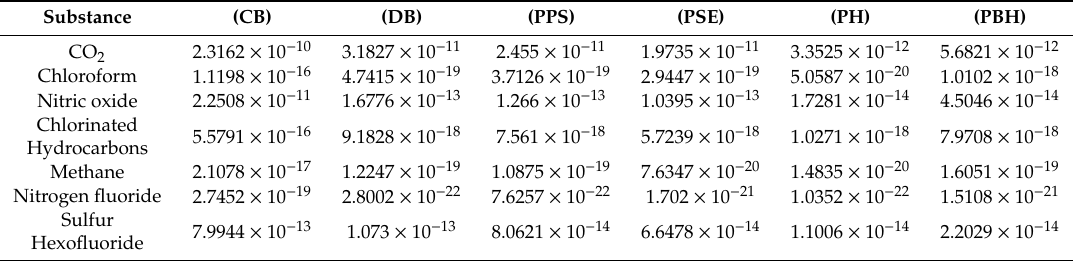
Table 8. Results of environmental impacts characterization for the category of global warming, land Table 9. Results of characterization of environmental impacts for the land acidification category ecosystems (species.yr).